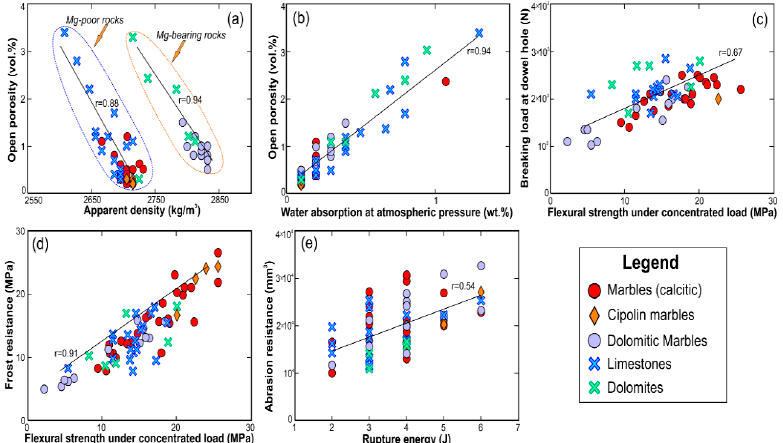
Figure 6. Binary diagrams of selected physico-mechanical properties: ( a )Apparent density – Open porosity, ( b ) Water absorption at atmospheric pressure – Open porosity, ( c ) Flexural strength under concentrated load – Breaking load at dowel hole, ( d ) Flexural strength under concentrated load – Frost Resistance, ( e ) Rupture energy—Abrasion Resistance. The regression lines (solid) and the correlation coefficient (r) values are also given.